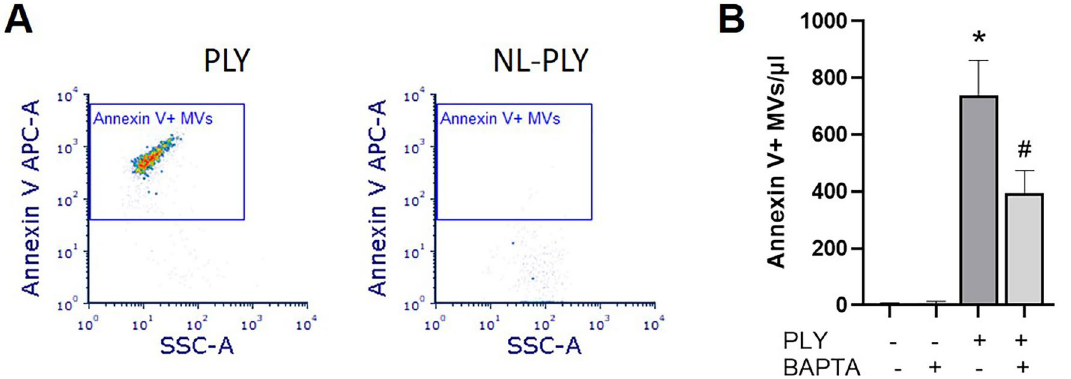
Figure 5. Pneumolysin (PLY) induces alveolar epithelial microvesicle (MV) release through pore formation and calcium influx. ( A ) A549 cells were treated with PLY or non-lytic (NL)-PLY (100 ng/ml) for 4 h and isolated MVs were analyzed by FACS. Depicted are representative dot blots of MVs after staining with annexin V. Positive events are indicated in the blue border gate. ( B ) A549 cells were pre-treated with BAPTA-AM (30 μΜ) for 1 h and then treated with PLY (100 ng/ml, 1 h). MVs were quantified by FACS after staining with annexin V. N = 3, *p < 0.001 vs Ctr, #p < 0.05 vs PLY (One-way